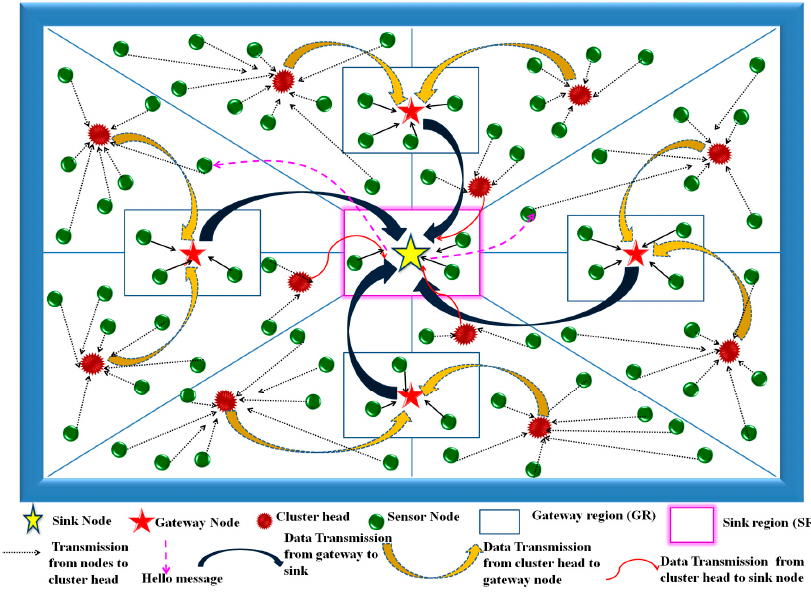
Figure 3. Schematic diagram showing the complete process of the MGBEHA protocol.